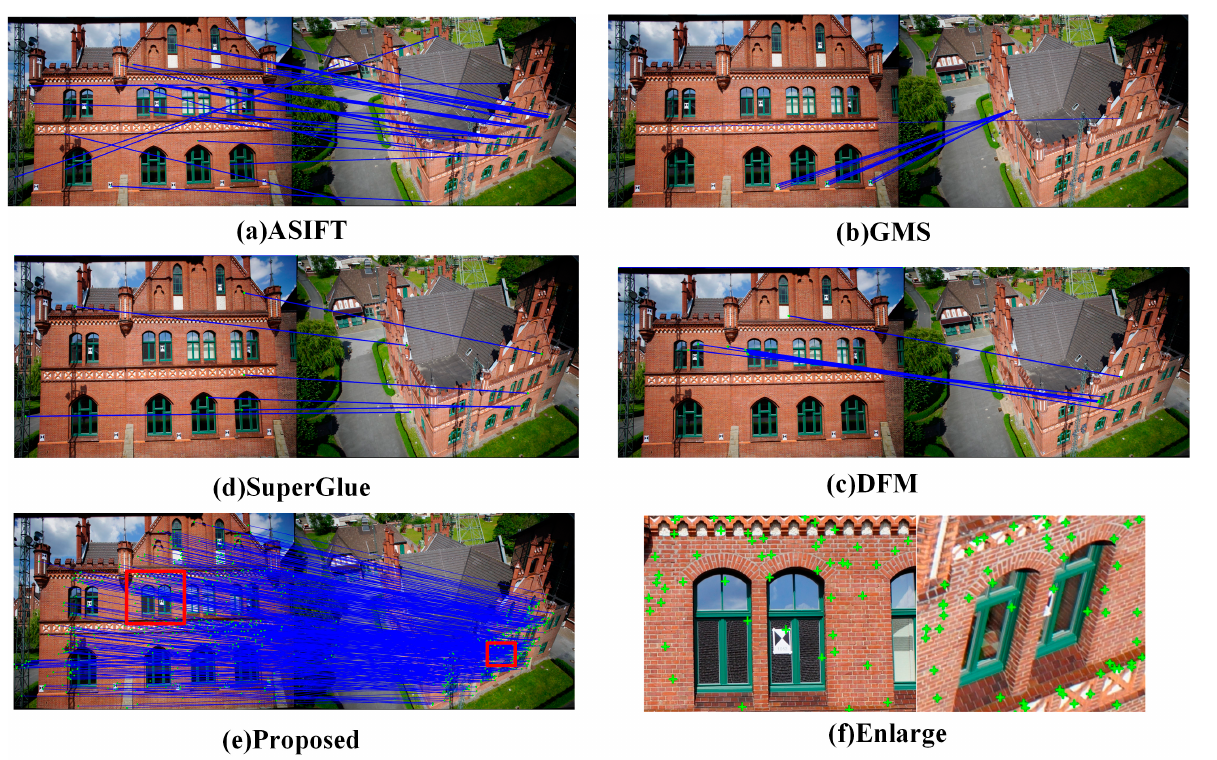
Figure 12. Image feature-matching comparison on the ZECHE ZOLLERN (Dortmund) dataset. ( a – e ) show the matching results of the ASIFT, GMS, DFM, and SuperGlue algorithms, respectively. ( e ) shows the matching result of the proposed algorithm, and ( f ) shows a magnified view of the matched feature points.